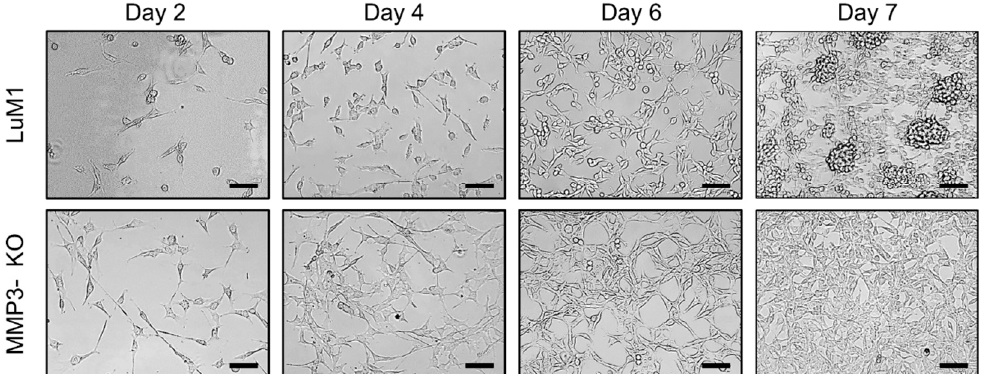
Figure 4. Representative images of re-cultured LuM1 and MMP3-KO cells in 2D culture. Tumoroids on day 14 were trypsinized and re-cultured under the 2D culture condition in serum-containing media. Scale bars, 100 μ m. The experiment was repeated twice.